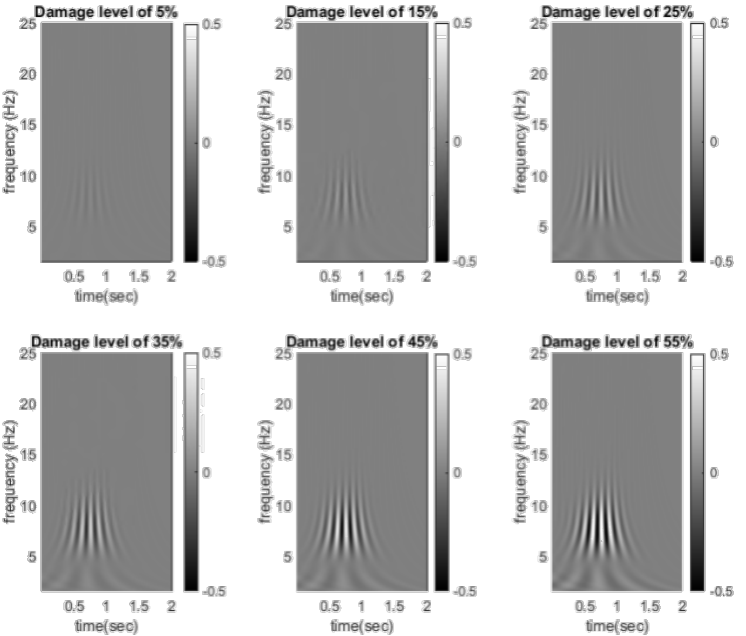
Figure 5. Difference between the real-valued CWT coefficients of healthy and six damage levels under speed of 105 kph .